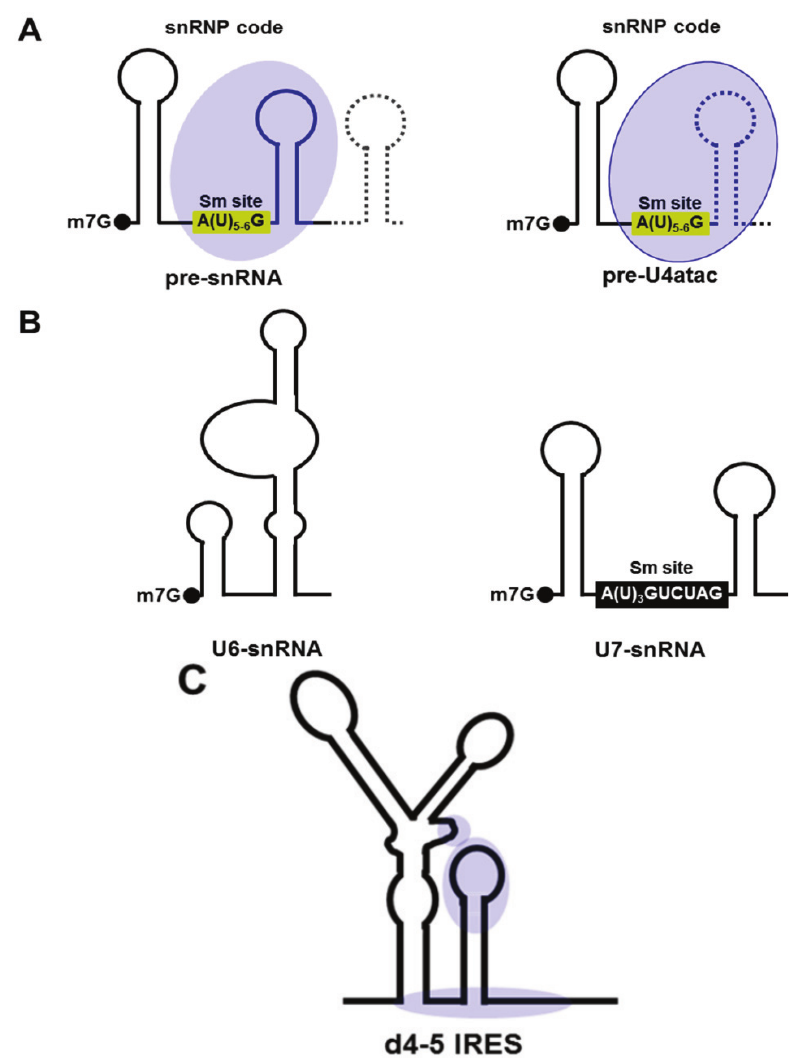
Figure 2. Schematic representation of the Gemin5 RNA targets. ( A ) The RNA target model represents U1, U2, U3, U11, U12 and U5 pre-snRNAs (left) and pre-U4atac snRNA (right). A yellow box depicts the canonical Sm site. The dotted line represents the RNA region that is removed in the mature form of snRNAs. A blue oval represents the Gemin5 binding site. ( B ) Schematic representation of U6 and U7-snRNAs, which are not targets of Gemin5. A black box represents the non-canonical Sm site. ( C ) Schematic representation of the binding sites of Gemin5 on domains 4 and 5 of the foot-and-mouth disease virus (FMDV) IRES (blue